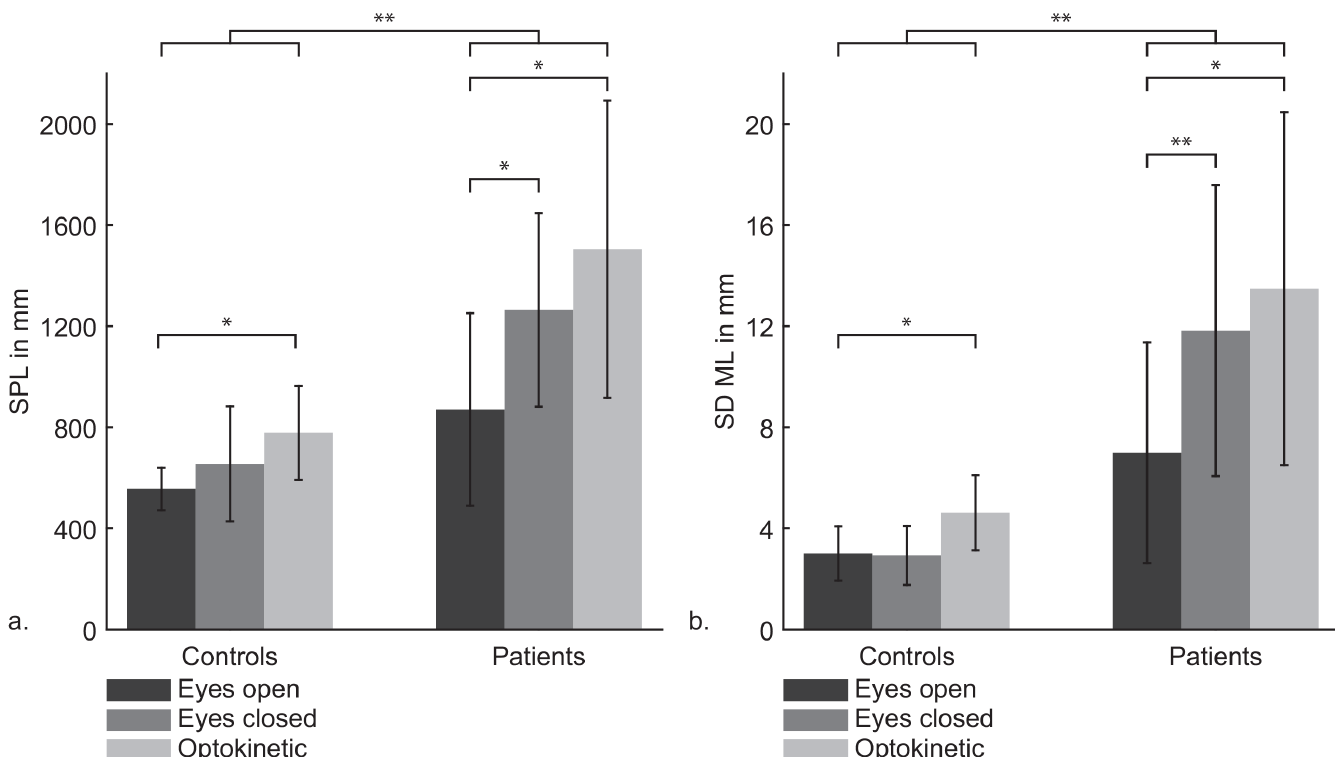
Fig 2. a. The sway path length (SPL) in mm ( ± SEM) and b. Standard deviation in mediolateral direction (SDML) in mm ( ± SEM) for both groups and all measurement types. VVM patients always exhibited a higher SPL and SDML than healthy controls. VVM patients were significantly more affected by visual deprivation (i.e. eyes closed versus eyes open) than healthy controls. Significant differences at p < . 05 , p < . 01 and p < . 0001 are indicated with * , ** , and *** , respectively. EC: eyes closed; EO: eyes open; OK: optokinetic.